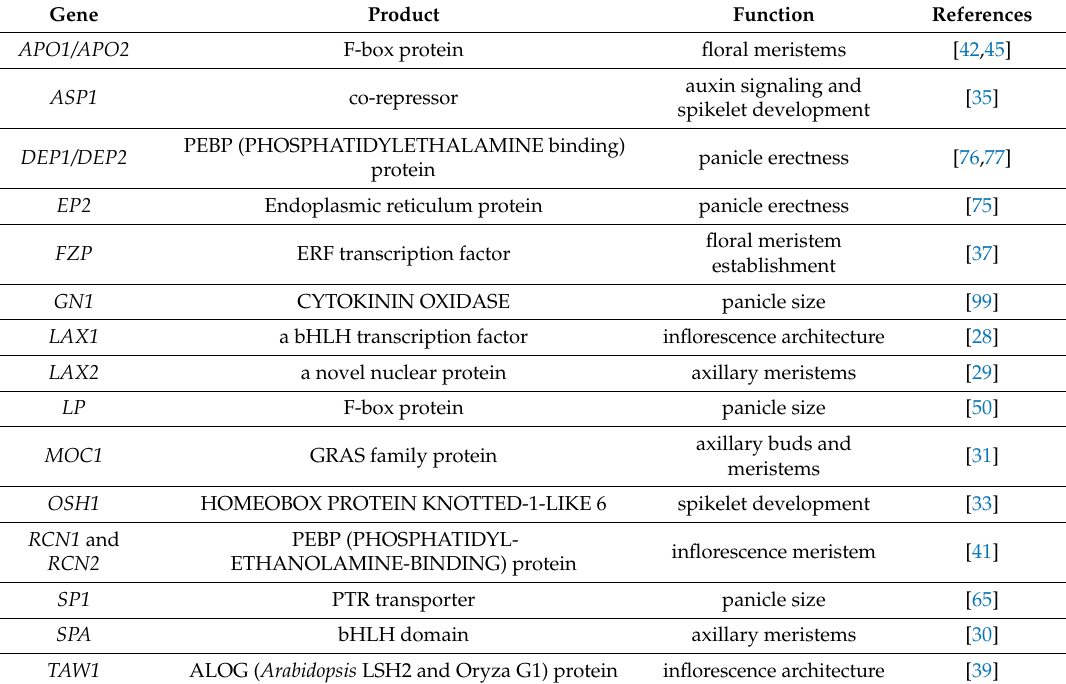
Figure 1. Hypothesized working model for an understanding of the molecular and physiological mechanisms governing panicle development and degeneration. The black arrows show the direct association of specific factors with the panicle degeneration. The dotted red arrows show the regulation of panicle degeneration by controlling the expression of genes that are mentioned above the arrow. The T-head arrows show the negative association of genes with panicle degeneration. The question mark reveals the elucidation mechanism is not reported in studies yet. Table 1. List of genes, their product, and function required for panicle